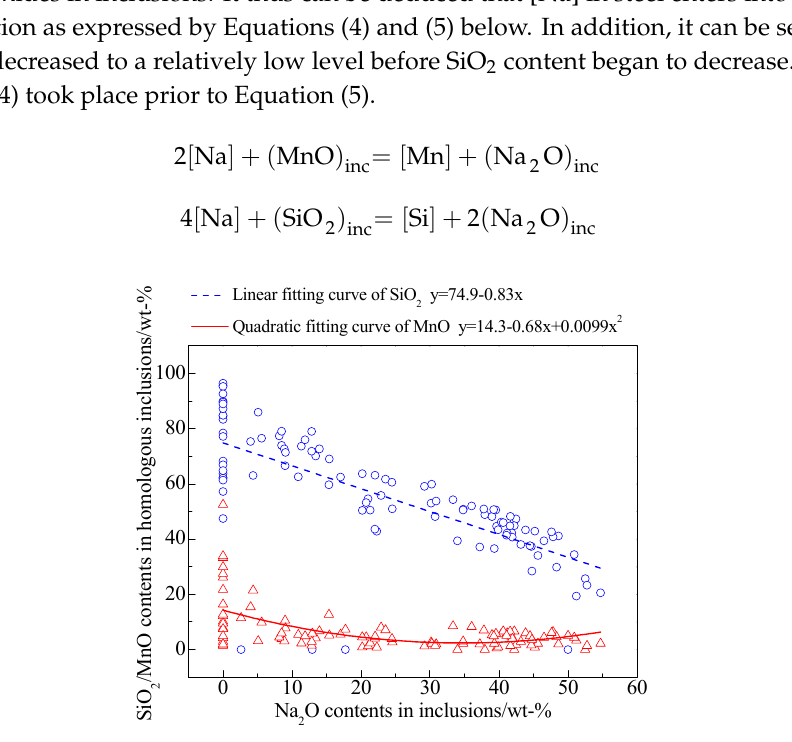
Figure 9. Compositional changes with Na 2 O content in inclusions from Heats A to C.